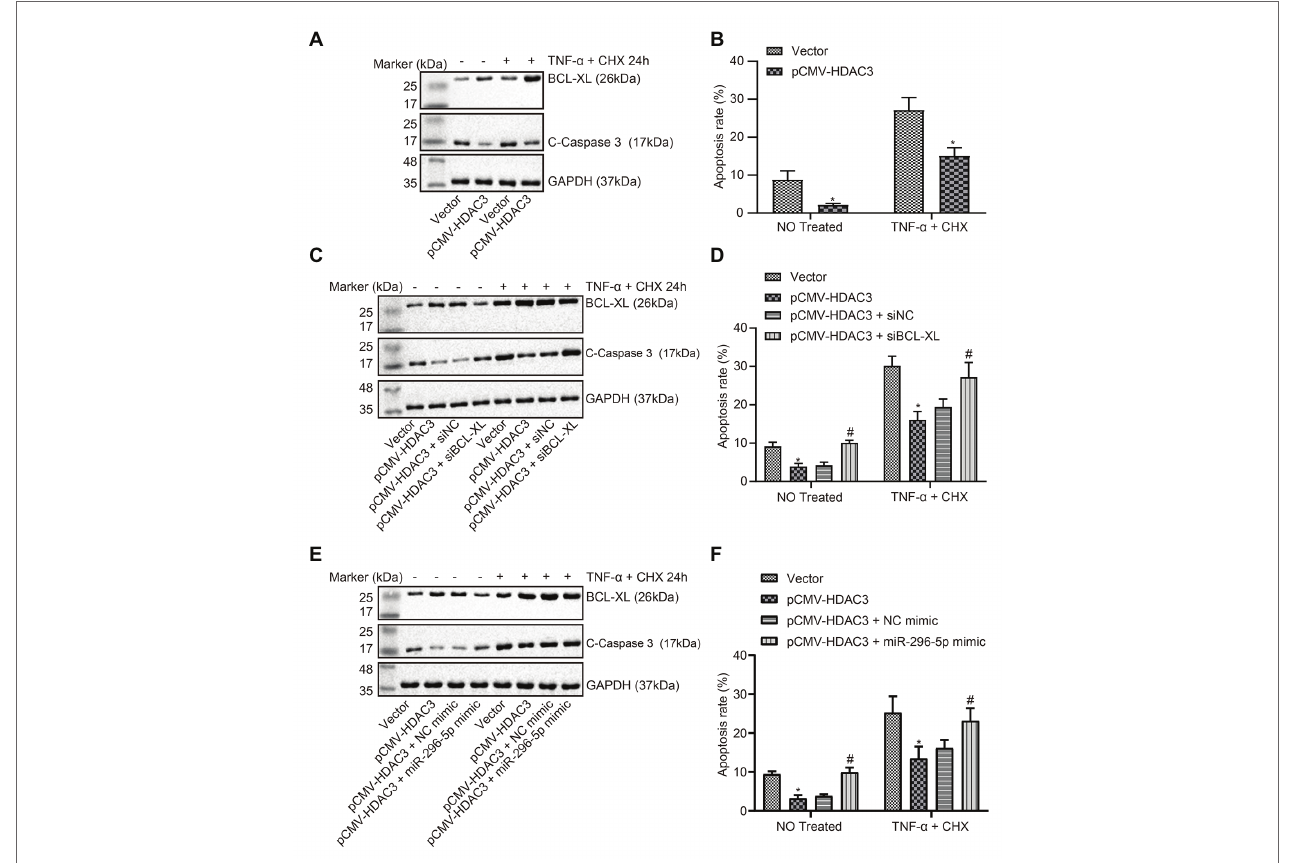
FIGURE 5 | HDAC3-mediated miR-296-5p attenuates the apoptosis of lymphocytes via the regulation of BCL-XL. (A) The expression of BCL-XL and C-caspase3 normalized to GAPDH determined by Western blot assay when HDAC3 was upregulated in lymphocytes. (B) The effect on apoptosis evaluated by flow cytometry when Hdac3 was upregulated in lymphocytes. (C) The effect of BCL-XL on the expression of C-caspase3 normalized to GAPDH after HDAC3 was downregulated in lymphocytes determined by Western blot assay. (D) The effect of Bcl-xl on apoptosis after Hdac3 was upregulated in lymphocytes evaluated by flow cytometry. (E) The effect of miR-296-5p on the expression of C-caspase3 normalized to GAPDH after HDAC3 was upregulated in lymphocytes tested by Western blot assay. (F) The effect of miR-296-5p on apoptosis after Hdac3 was upregulated in lymphocytes tested by flow cytometry. * p < 0.05 compared with cells transfected with vector, # p < 0.05 compared with cells transfected with pCMV- Hdac3 + si-NC or pCMV- Hdac3 + NC mimic. The results were measurement data and expressed as mean ± standard deviation. Data comparison between two groups was performed using unpaired sample t -test, and data comparisons among multiple groups were performed using one-way analysis of variance. The cell experiment was repeated three times